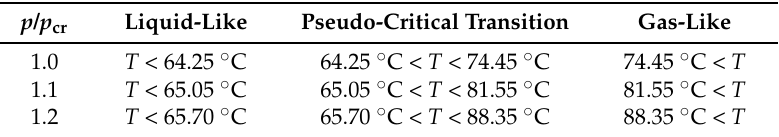
Table 3. Flow regime